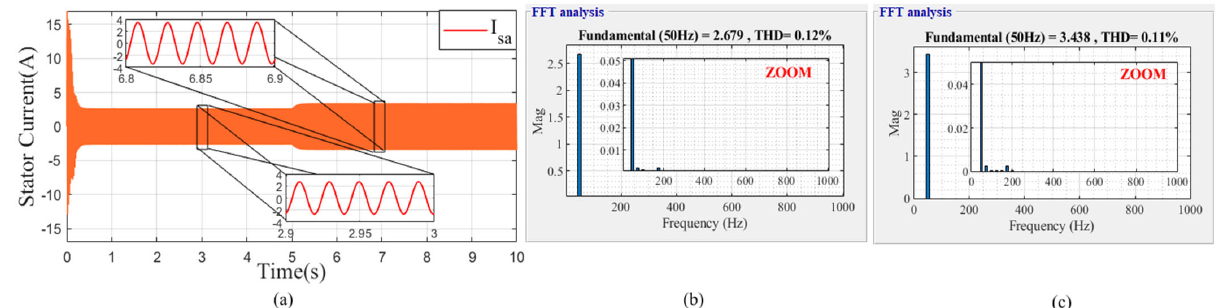
Figure 19. Performance in healthy state of IM without control: ( a ) Stator current and ( b ) THD at no ‐ load and ( c ) THD with load (5 Nm).